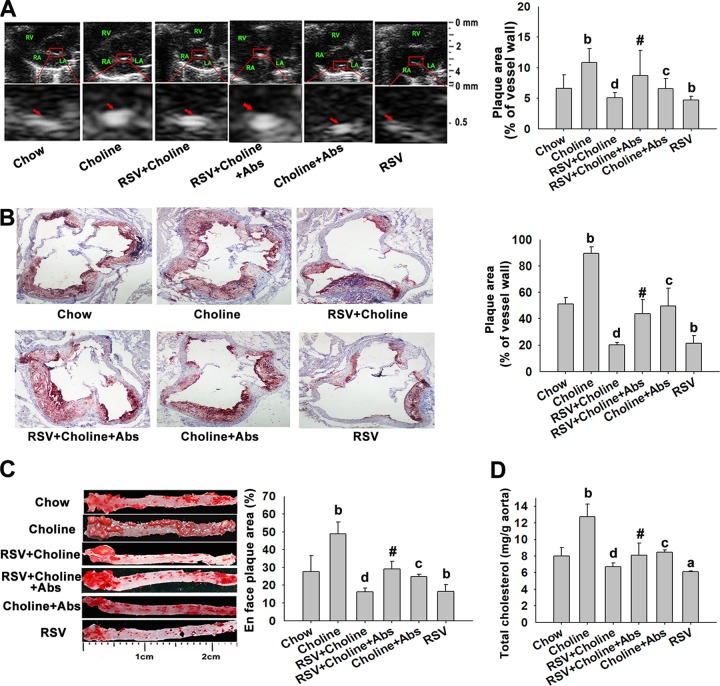
RSV protected ApoE−/− mice from TMAO-induced AS. Eight-week-old female ApoE−/− mice (n = 10 per group) were given RSV (0.4%) with or without choline (1%) in the absence or presence of Abs for 4 months. The control group was fed with a chow diet. (A) Ultrasound B-mode images of the aortic sinus and quantification. Arrows indicate the regions of interest. RV, right ventricle; RA, right atrium; LA, left atrium. (B) Oil red O-stained aortic roots (counterstained with hematoxylin) and quantification. (C) Oil red O staining of whole aortas, including the aortic arch, thoracic, and abdominal regions, and their quantitation. (D) Total cholesterol content in the thoracic and abdominal aorta. Values are expressed as means ± SD (n = 10). a, P < 0.05; b, P < 0.01 (versus vehicle-treated control group); c, P < 0.05; d, P < 0.01 (versus choline-treated group); #, P < 0.05 (versus group cotreated with RSV and choline).